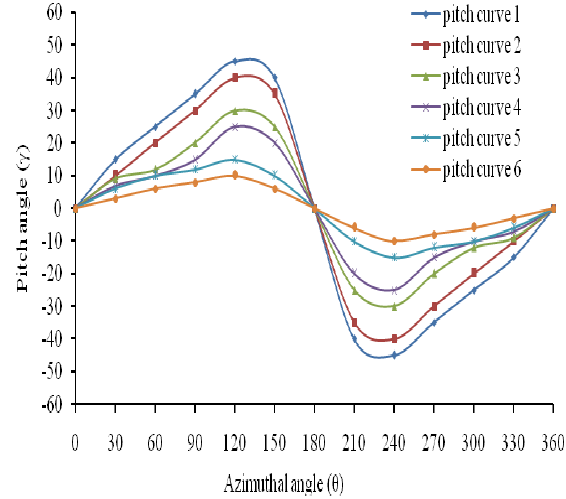
Figure 2. Pitching Schedule Curves for different λ